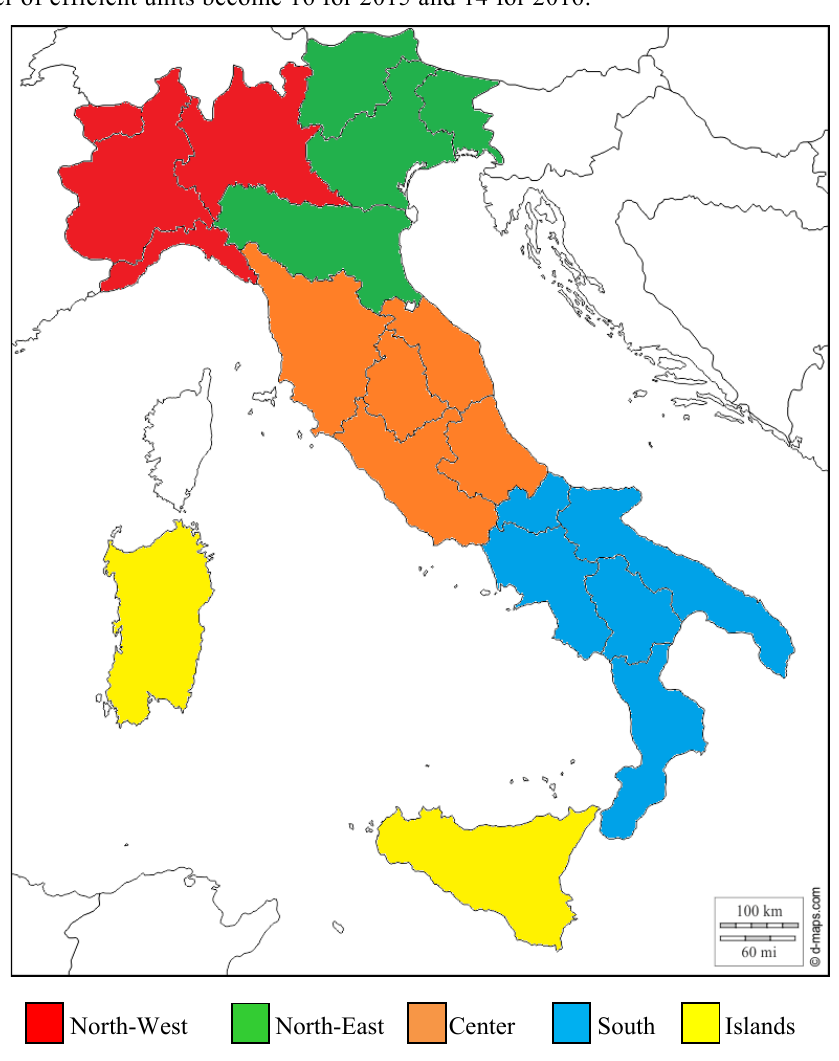
Fig. 1. Italy and its aggregated